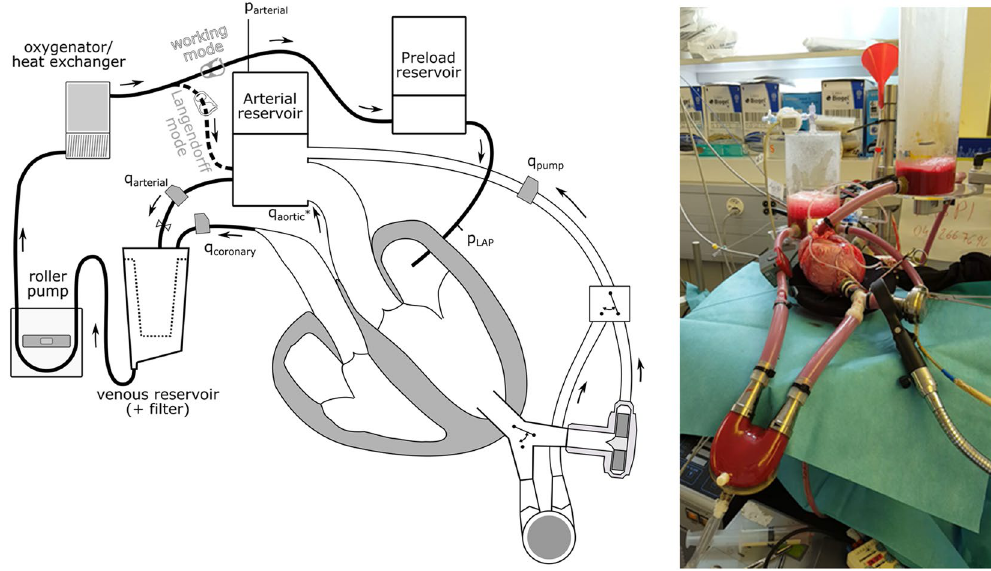
Figure 6. Schematic diagram and picture of the isolated heart setup in Working Mode (adapted from Granegger et al . 25 ) with the pumps